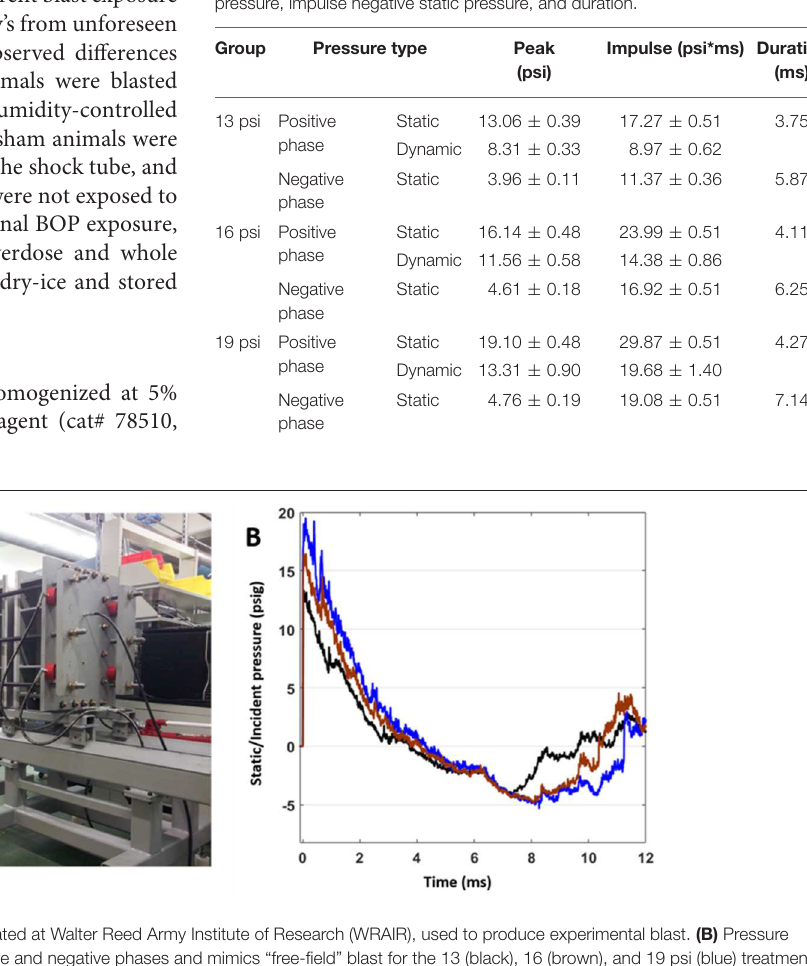
TABLE 1 | Pressure profiles of 13, 16, and 19 psi treatment groups, including: peak positive static pressure, peak positive dynamic pressure, peak negative